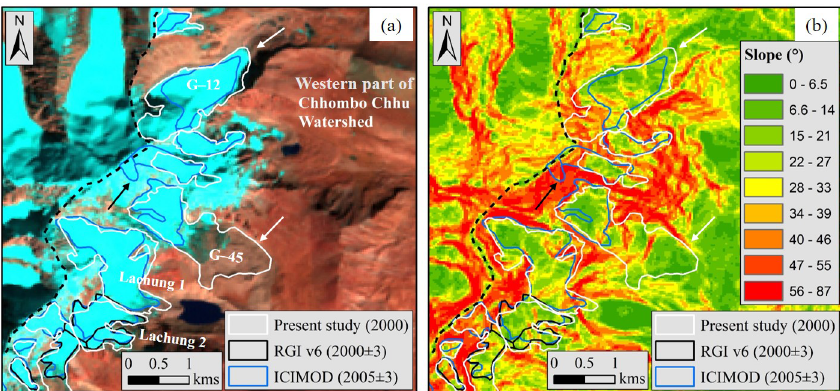
Figure 13. Glacier inventory: (a) overlay of glacier outlines of different inventories on Landsat 7 ETM + 8 November 2000 image; (b) slope map (in ◦ ) showing the misinterpretation of glacier boundary and ice and sub-watershed divides. Dashed black lines represent the watershed